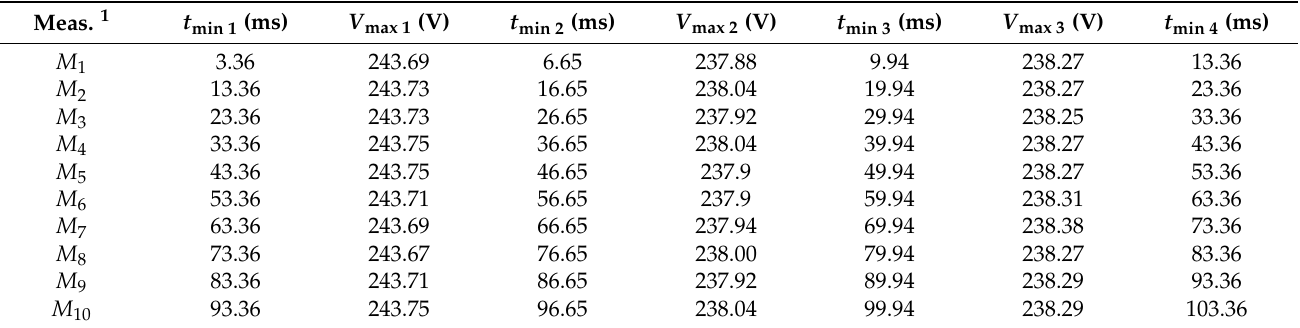
Table 3. Ten measurements of 3 consecutive maximum values of the DC voltage and 4 consecutive time values in which the DC voltage has its minimum values. The values correspond to the DC voltage profile shown in Figure